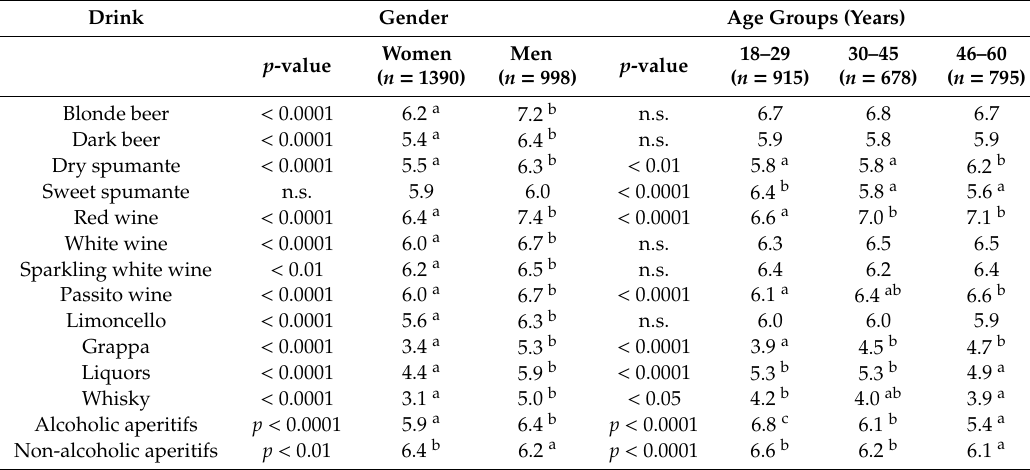
Table 2. E ff ect of gender and age on mean liking (9-point hedonic scale) of alcoholic beverages. Di ff erent superscripts indicate significant di ff erences according to Bonferroni post-hoc test (n.s. = not